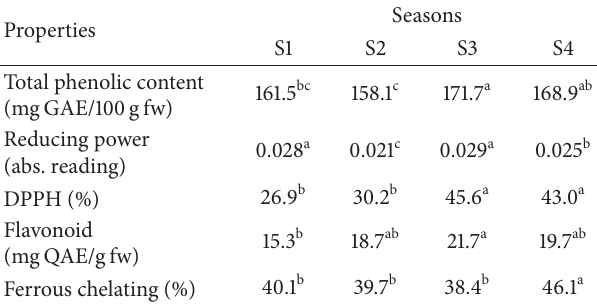
Table 2: Phytochemicals of rice cultivars (mean values of 2 years) as